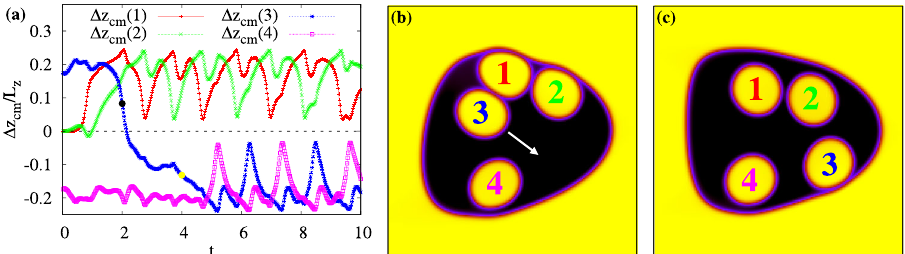
Fig. 9 Level crossing in a four-core emulsion. a Time evolution of the displacement Δ z cm of four cores. Drops 1 and 2 (red/plusses and green/crosses, respectively) exhibit a periodic motion in the upper part of the emulsion whereas cores 3 and 4 (blue/asterisk and pink/square) in the lower one, once a crossing has occurred. The black dotted line is a guide for the eye representing the separation between the two regions of the emulsion. Panels b and c show the positions of the internal droplets during the crossing of droplet 3. They are taken at t = 2 × 10 5 ( a ) and t = 4 × 10 5 ( b ), marked by two spots (black and yellow) in ( a ). A white arrow indicates the direction of motion of